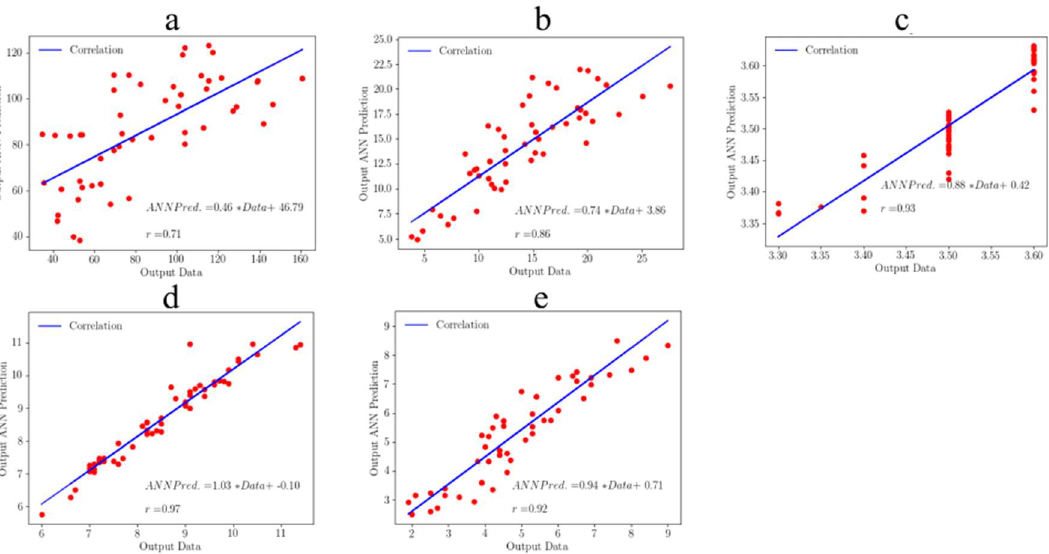
Figure 11. Correlation between output ANN prediction and output data for the testing dataset ( a ) Phenols, ( b ) Flavonoids, ( c ) pH, ( d ) Viscosity, ( e ) Color. ( a ) Phenols, ( b ) Flavonoids, ( c ) pH, ( d ) Viscosity, ( e )